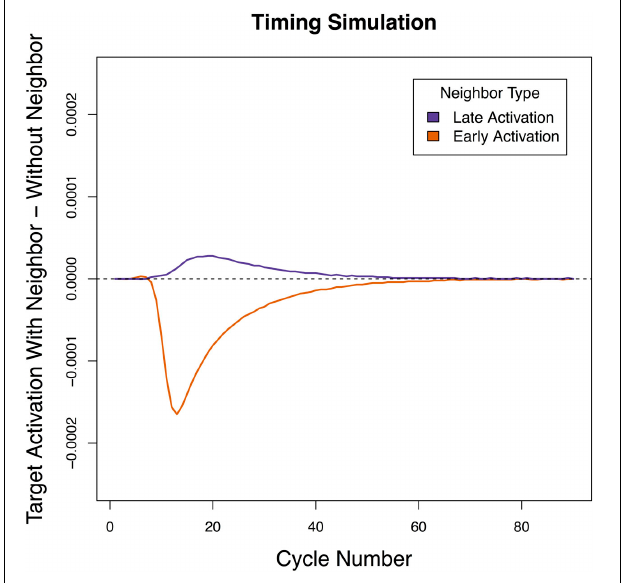
FIGURE 4 | Net contribution of a handshape neighbor and a location neighbor when the resting level of activation of sub-lexical units was manipulated. Handshape neighbors had a net facilitatory effect on the target, while location neighbors had a net inhibitory effect on the